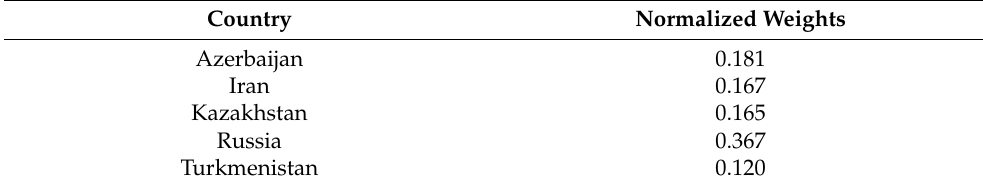
Table 3. The normalized weights of each state in the Caspian negotiation (the original weights were previously estimated by Shikhmohammady et al.